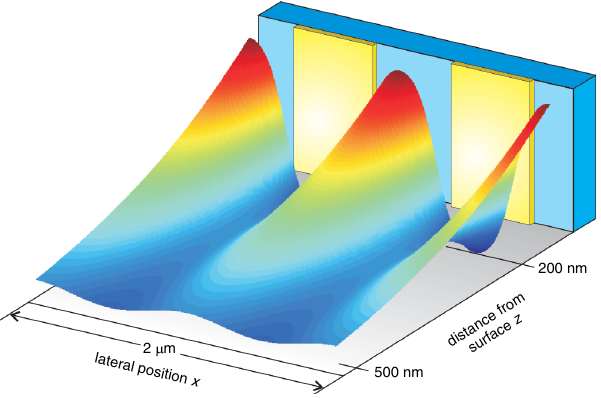
¼ 2 π ℏ ¼ dB mv